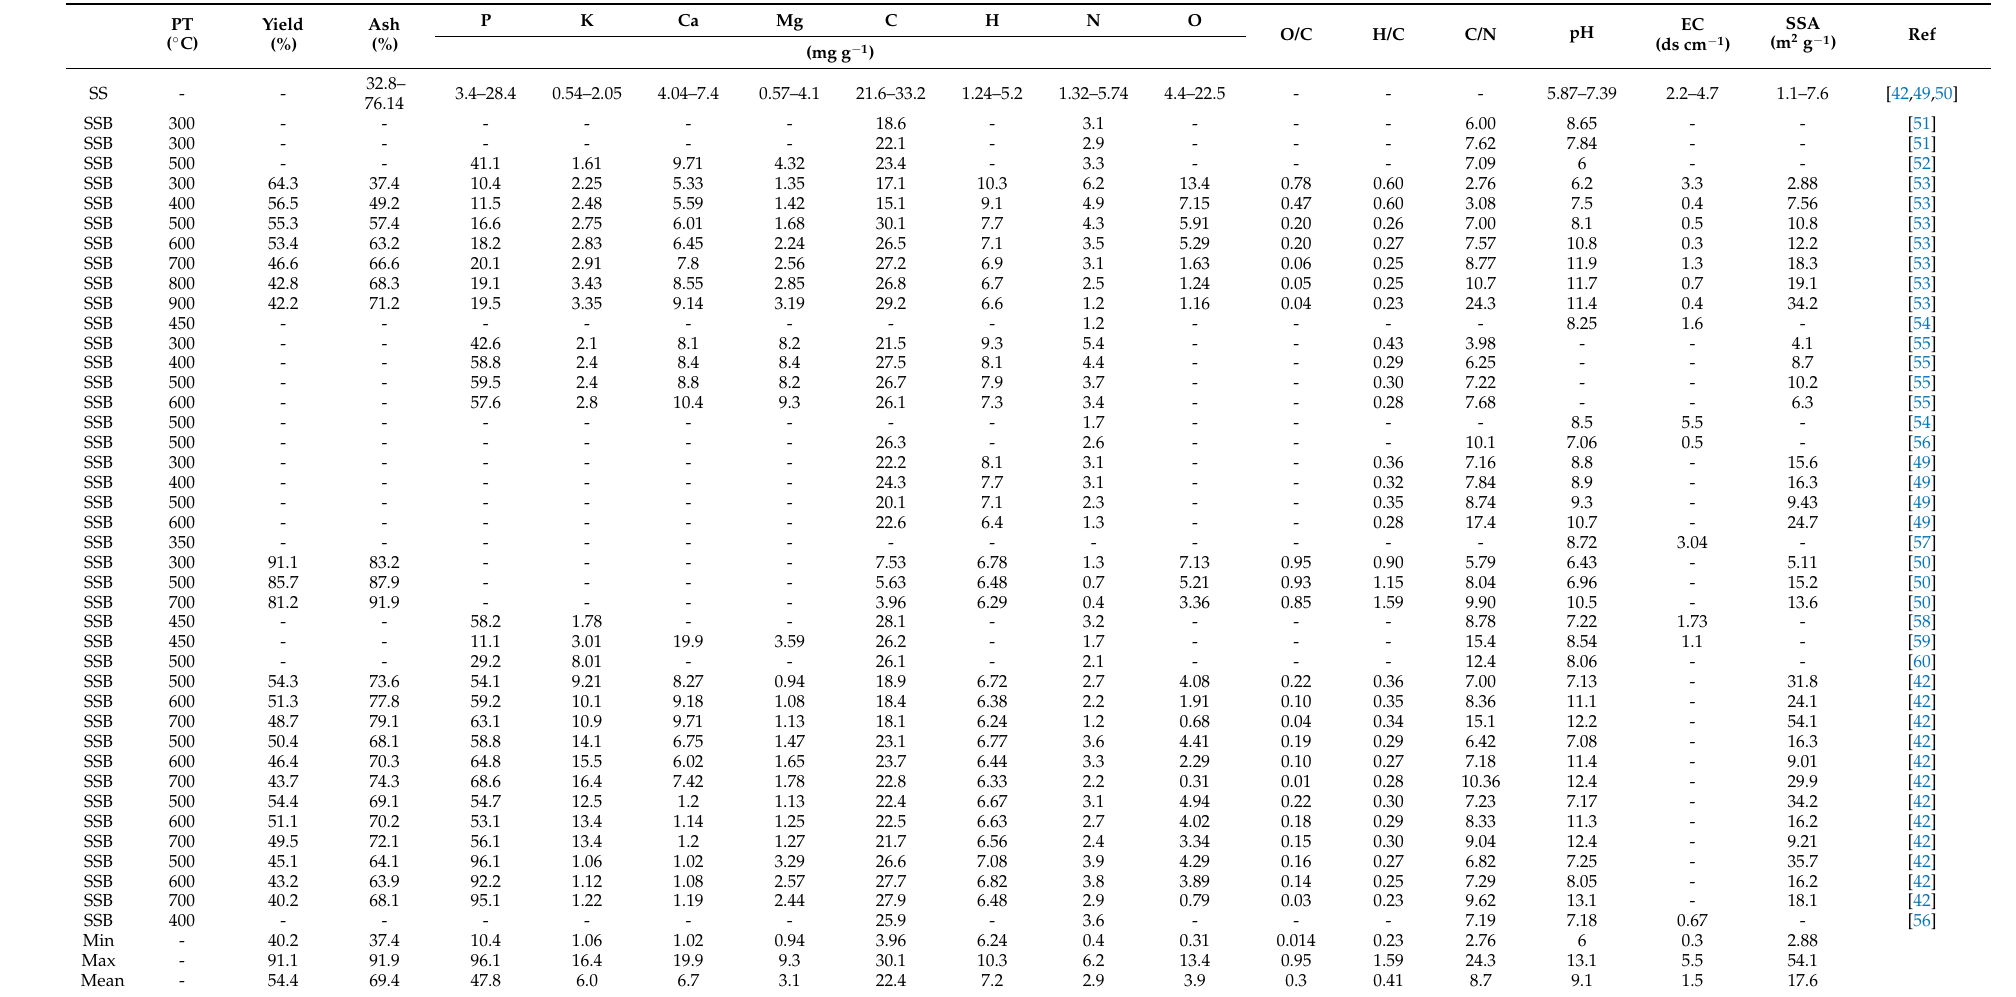
Table 1. Summary of selected properties of SS and